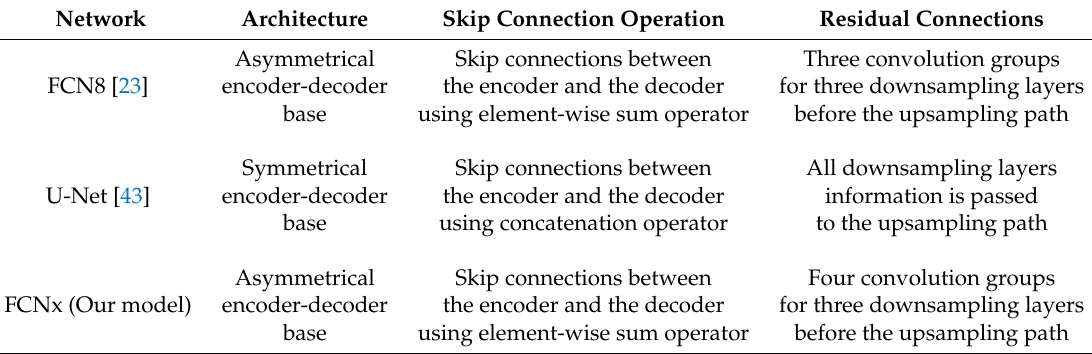
Table 1. Comparison of our FCNx architecture with FCN8 and U-Net